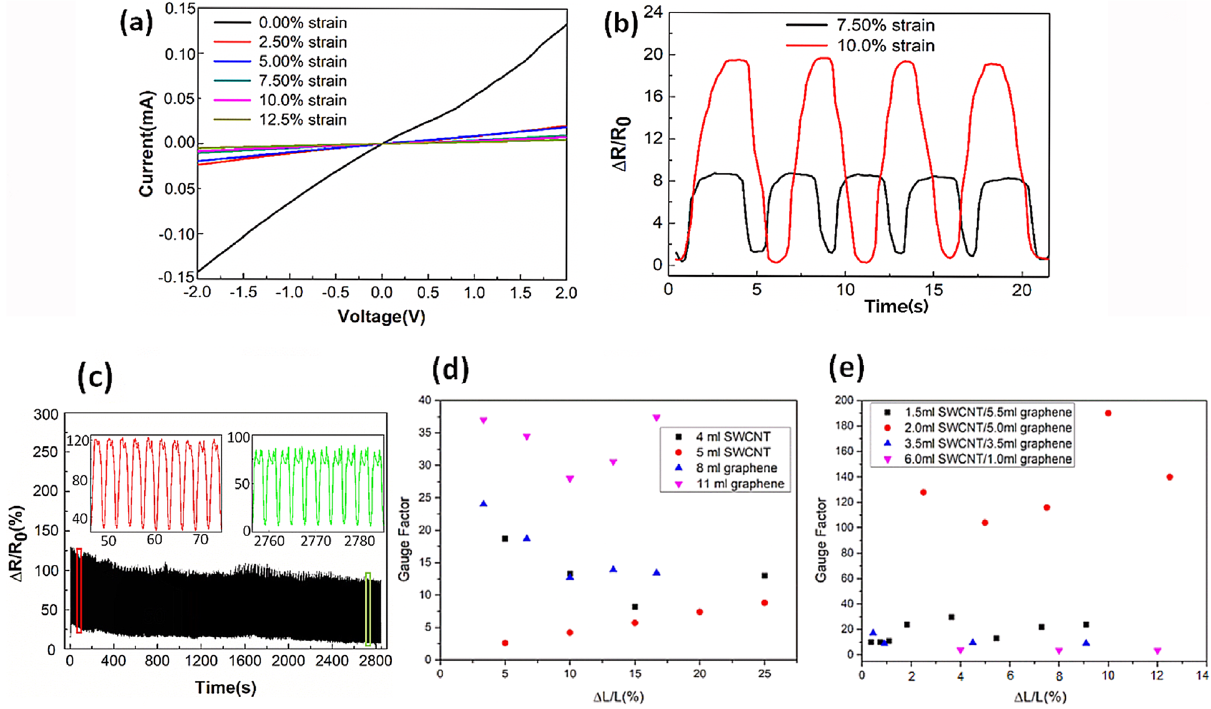
Figure 5. Piezoresistive performance of thin film sensors. ( a ) Measured I-V curves of the GNP-CNT hybrid thin film strain sensor with various applied strain levels. ( b ) The ΔR/R responses of the GNP-CNT hybrid thin film sensor under 7.5% strain and 10% strain. ( c ) Plot of the resistance response over 1000 loading/unloading cycles at a strain of 10%. ( d ) Effect of different strain level on the gauge factors of sole CNTs and sole graphene thin film sensors. ( e ) Effect of different strain level on the gauge factors of GNP-CNT hybrid thin film strain sensor with different GNP/CNTs ratio. The optimal volume ratio of graphene dispersion to CNTs dispersion is 5:2.